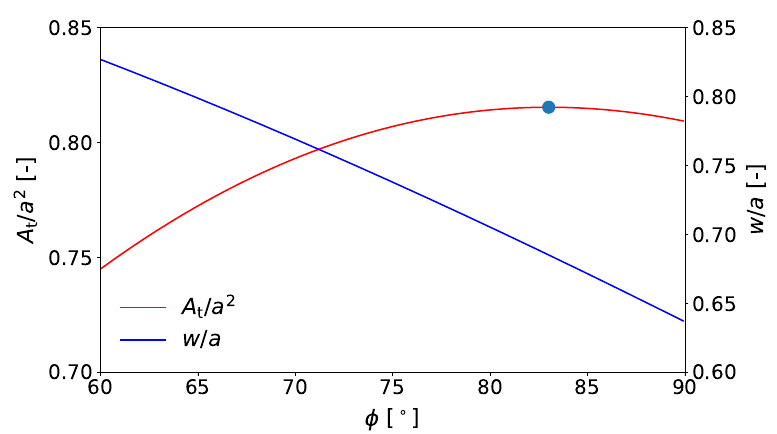
Figure 8. The non-dimensional cross-sectional area and the width of an inflated quarter segment as functions of the angle φ .